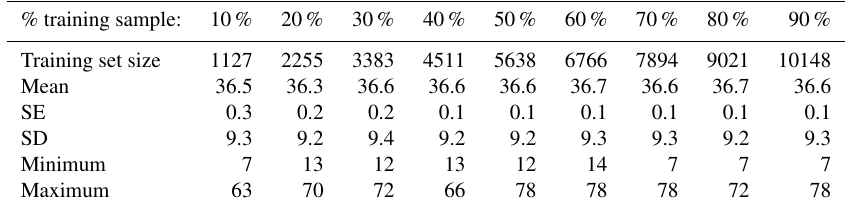
Table A2. Descriptive statistics of different training